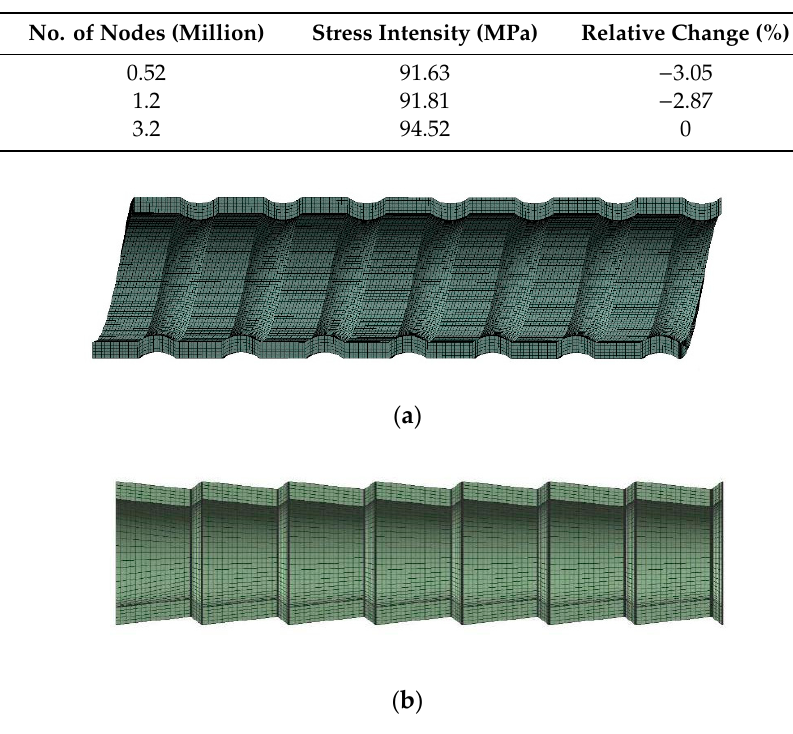
Figure 4. Mesh models of two HEHE tubes: ( a ) SG tube, ( b ) CD tube. Table 5. Results of grid independence test for SG tube.